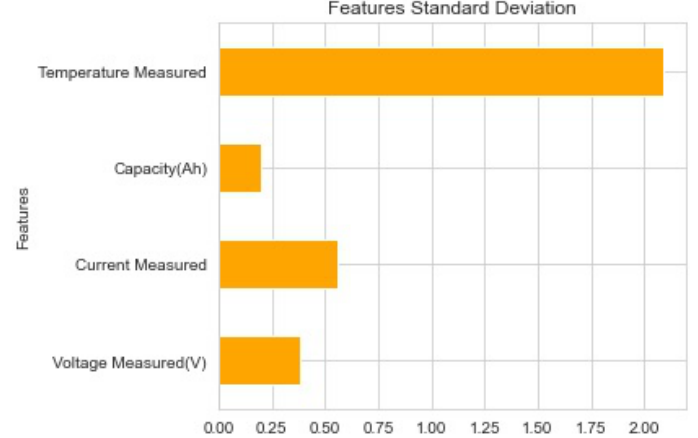
Figure 7. Features’ standard